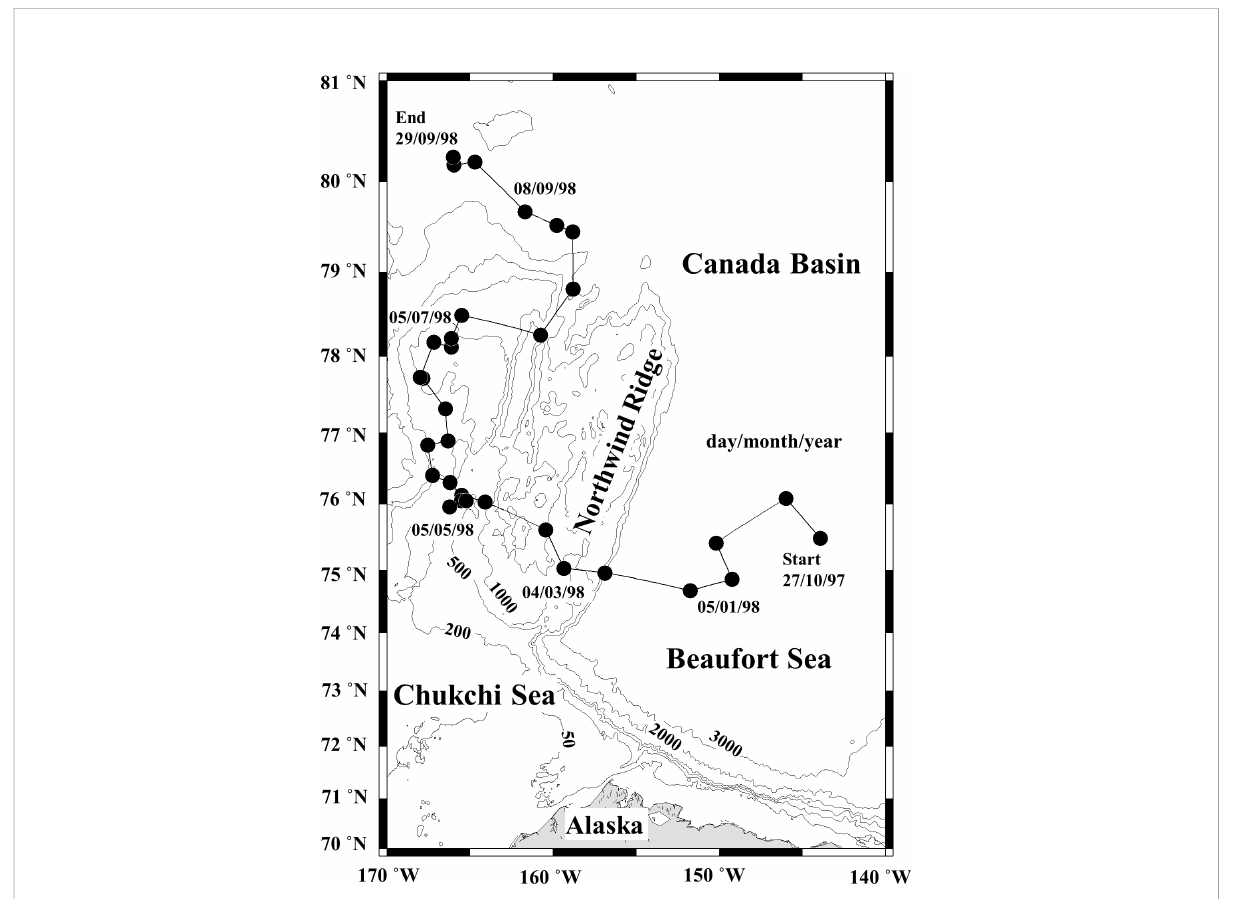
FIGURE 1 Location of the zooplankton sampling sites (black circles) along the drift track of the Surface Heat Budget of the Arctic Ocean (SHEBA) ice station through the Canada Basin to the Mendeleev Plain from 27 October 1997 to 29 September 1998 (cf. Ashjian et al.,